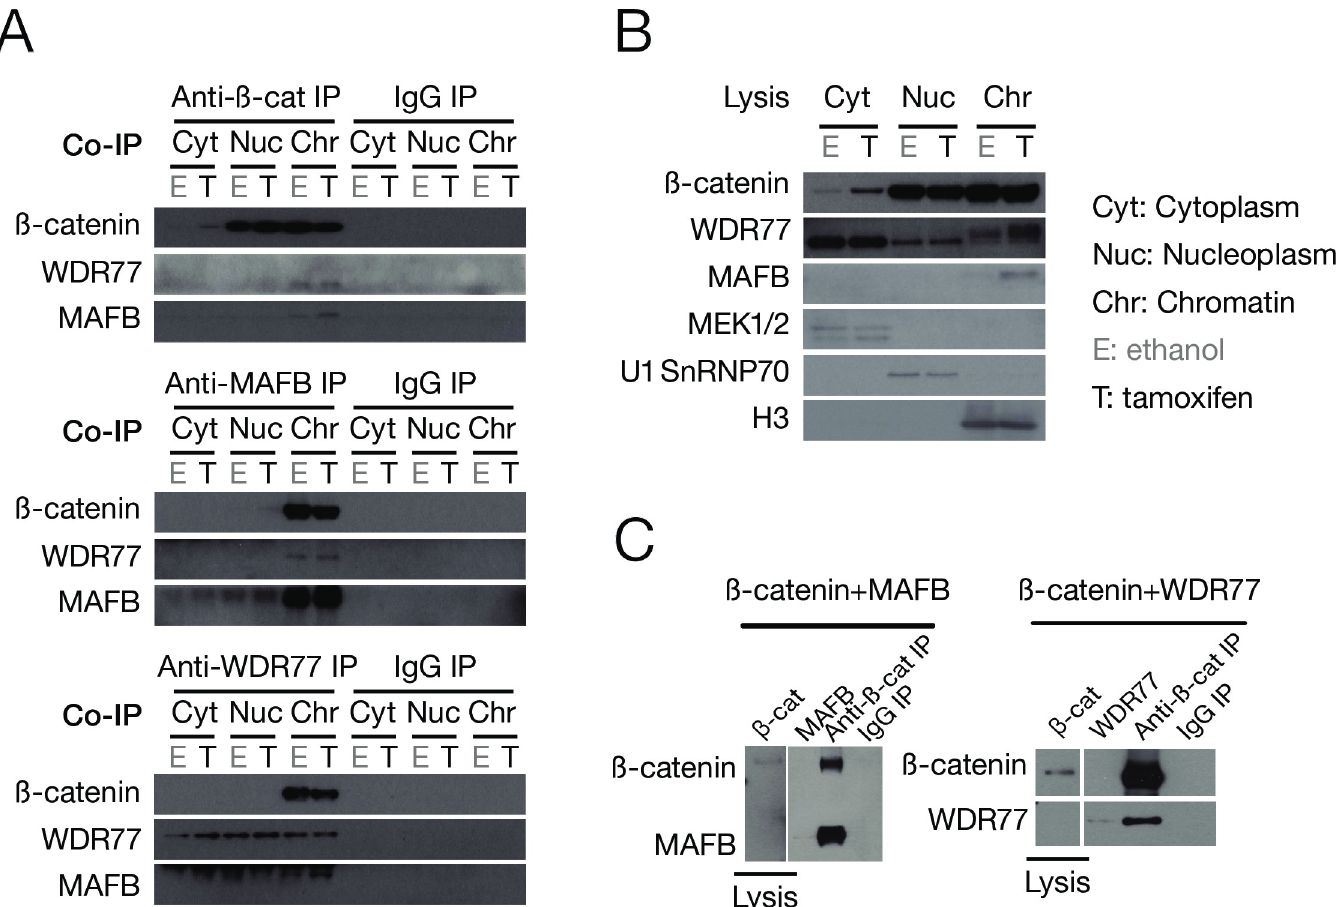
Fig 2. The direct interaction of β -catenin, MafB, and WDR77. (A) Co-IP of endogenous β -catenin, MafB, and WDR77 proteins in the cytoplasm (Cyt), nucleoplasm (Nuc), and chromatin (Chr) fractions of transformed (T) and non-transformed (E) cells. IgG was used as a co-IP control. (B) Western blots of the indicated proteins in fractions from the cell-free extract prior to the co-IP. Fractions are defined by MEK1/2 (cytoplasm), U1 SnRNP70 (nucleoplasm), and H3 (chromatin). (C) co-IP of recombinant β -catenin, MafB, and WDR77 proteins.